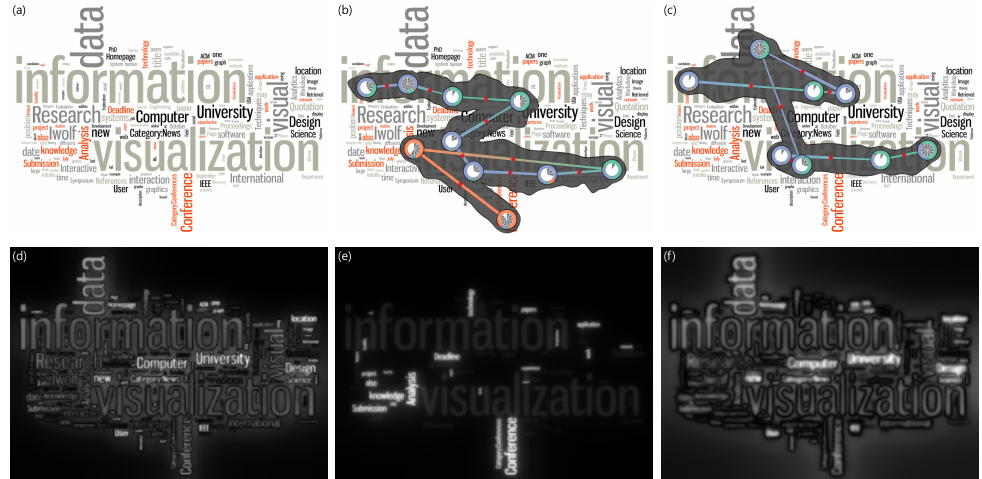
Figure 4. Gaze analysis on the tag cloud visualization. ( a ) is the visual stimulus. ( b , c ) are the saliency-based gaze visualizations of two participants. ( d – f ) are the intensity, color, and orientation feature map,